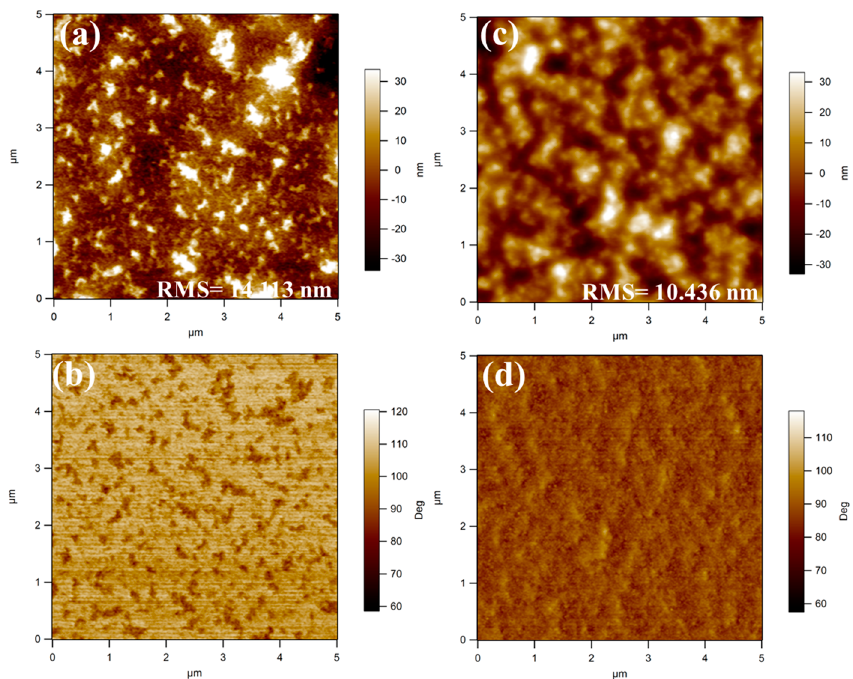
Figure 10. Tapping atomic force microscopy (AFM) height (top) and phase (bottom) images for photoactive layers of PBDT-TVT-BT/PC 71 BM (1:1.5, 3% DIO, a , b ) and PBDT-TVT-FBT/PC 71 BM (1:1.5, 3% DIO, c , d ).